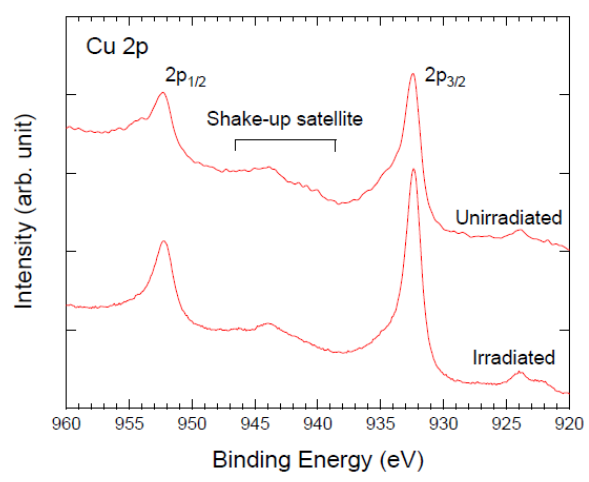
Figure 5. XPS Cu 2p core level photoemission spectra of the unirradiated and irradiated areas in the sample irradiated with 5 keV-Ar + ions to a fluence of 1 × 10 15 cm − 2 .